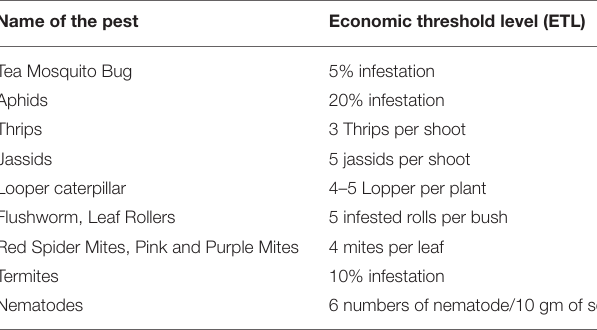
TABLE 2 | Economic Threshold Level (ETL) of major pests of tea